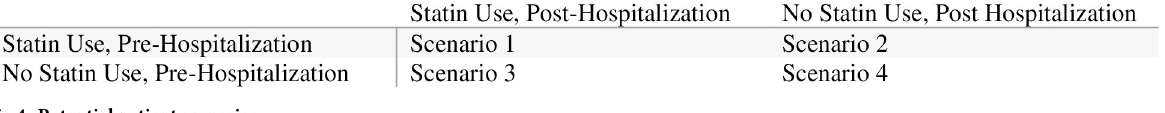
Fig 4. Potential patient scenarios.